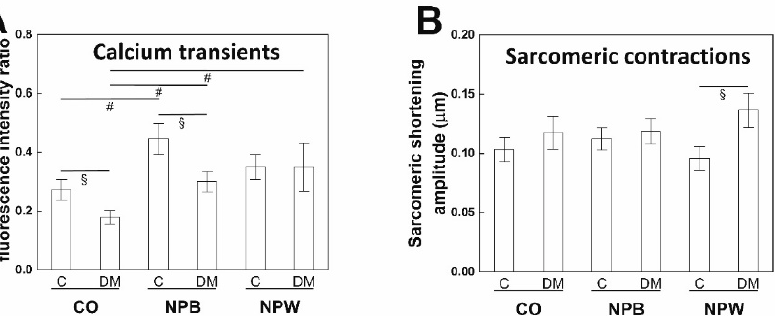
Figure 5. Functional measurement was performed on cardiomyocytes isolated from the left ventricle of the control rats and Zucker diabetic fatty rats with type 2 diabetes mellitus. ( A )—Comparison of calcium transient amplitudes between the control and diabetic animals in the control solution, the solution containing NPB (0.1 µM), and the solution containing NPW (0.1 µM). n = 12–20 in each group. ( B )—Comparison of sarcomeric shortening amplitudes between the control and diabetic animals in the control solution, the solution containing NPB (0.1 µM), and the solution containing NPW (0.1 µM). n = 16–23 in each group. Data are presented as mean ± SEM. Values of p < 0.05 were considered statistically significant. § —significantly different from the control animals (Mann–Whitney test). #—significantly different from the control solution (Mann–Whitney test).